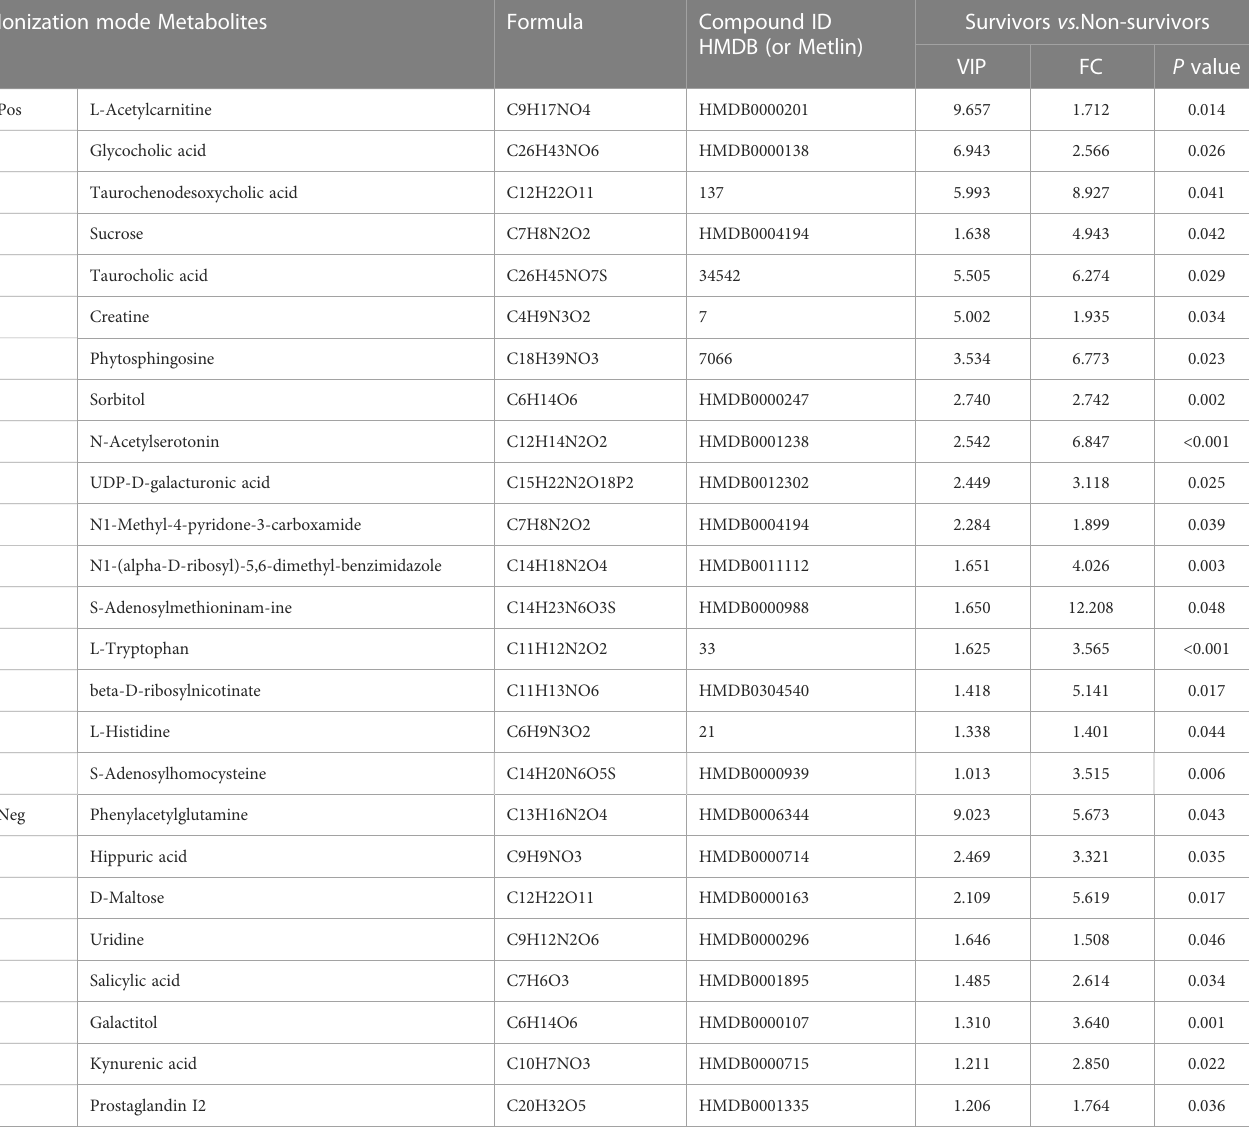
TABLE 3 In two ionization modes, differential metabolites between survivors and non-survivors.